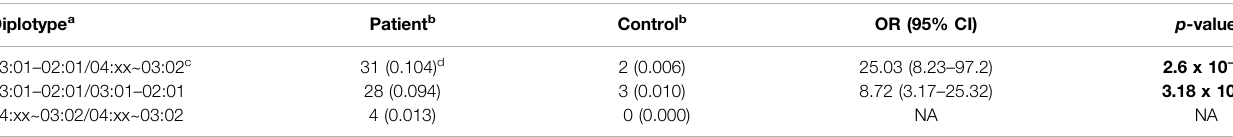
TABLE 5 | Associations of DRB1 ~ DQB1 diplotypes with T1D in the study subjects. Diplotype a Patient b Control